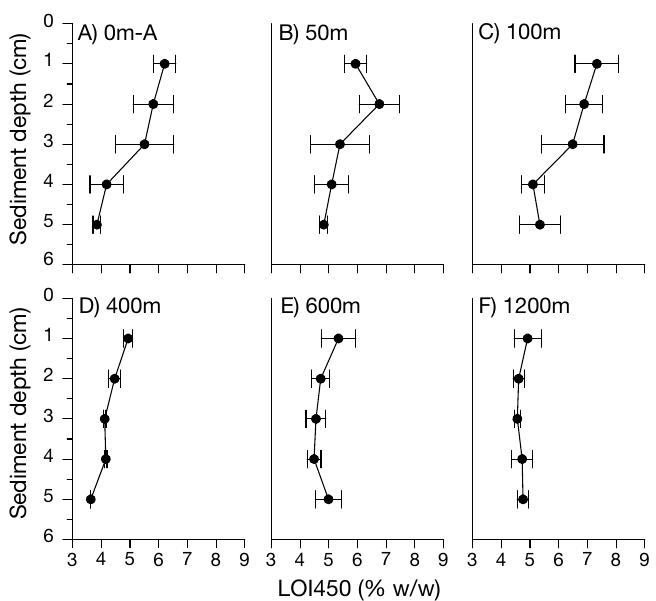
Fig. 3. Organic content (determined as the weight loss after ig- nition at 450°C, LOI450) of sediment with depth (1 cm bins to 5 cm) and distance to nearest farm, from 0 to 1200 m during the pre-harvest survey. Error bars represent ±1 SE